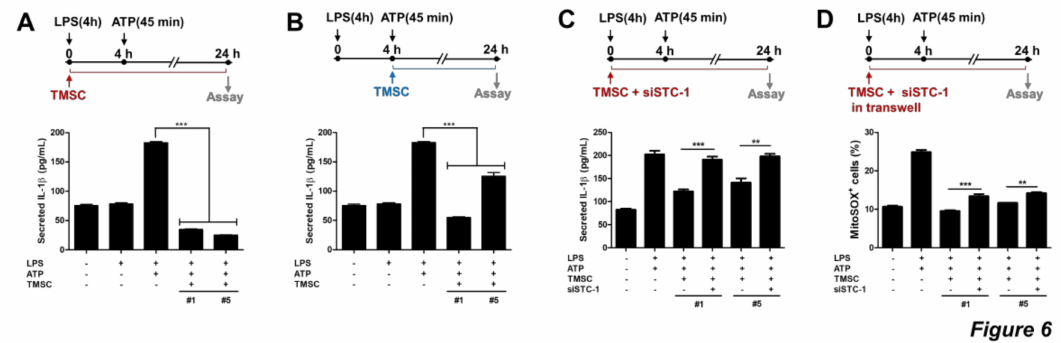
Figure 6. ROS regulation in THP1-derived macrophage-like cells by STC1. THP1-derived macrophage like cells were stimulated with LPS and ATP for NLRP3 activation and co-cultured with human TMSCs. IL-1 β production was detected by ELISA ( A – C ). TMSCs were added to macrophages at LPS priming step ( A ) or at ATP stimulation step ( B ), and NLRP3 activation was assessed by IL-1 β secretion. Untreated or siSTC1-treated TMSCs were co-cultured with THP1-derived macrophages from LPS priming step ( C ). After 24 h of co-culture, IL-1 β secretion in the supernatants was quantified by ELISA ( A – C ). After 24 h of co-culture using transwell, mitochondrial ROS level was measured by staining with mitoSOX. mitoSOX + cells were determined by flow cytometry and quantified ( D ) Results are three technical replicates of TMSCs from one donor. Representative results from two di ff erent TMSCs with similar tendency were presented. ** P < 0.005, *** P < 0.001. Results are shown as mean ±